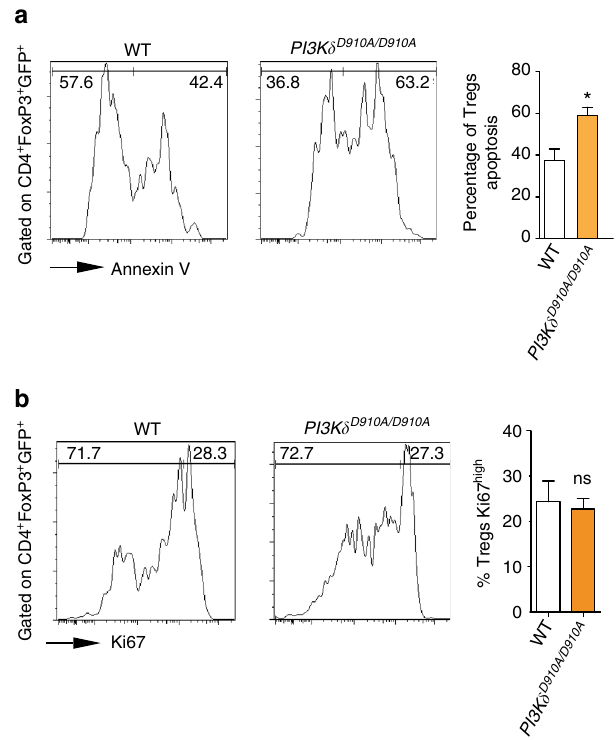
Fig. 5 PI3K δ inhibition abrogates Treg survival. a Representative examples of Annexin staining of WT and PI3K δ D910A/D910A nTregs transferred in the spleen of C57BL/6 mice induced with GVHD. Bar graph represents the different percentages. (* p < 0.05, t -test, n = 3/group). b Representative examples of Ki67 expression of WT and PI3K δ D910A/D910A nTregs the different percentages. (* p < 0.05, t -test, n = 3/group). a , b The